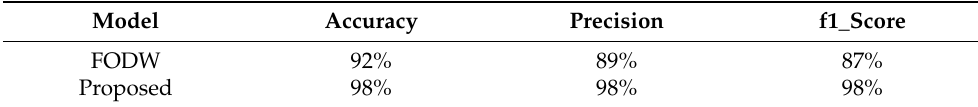
Table 9. Comparison of the Proposed Model with the Existing Algorithm [61].